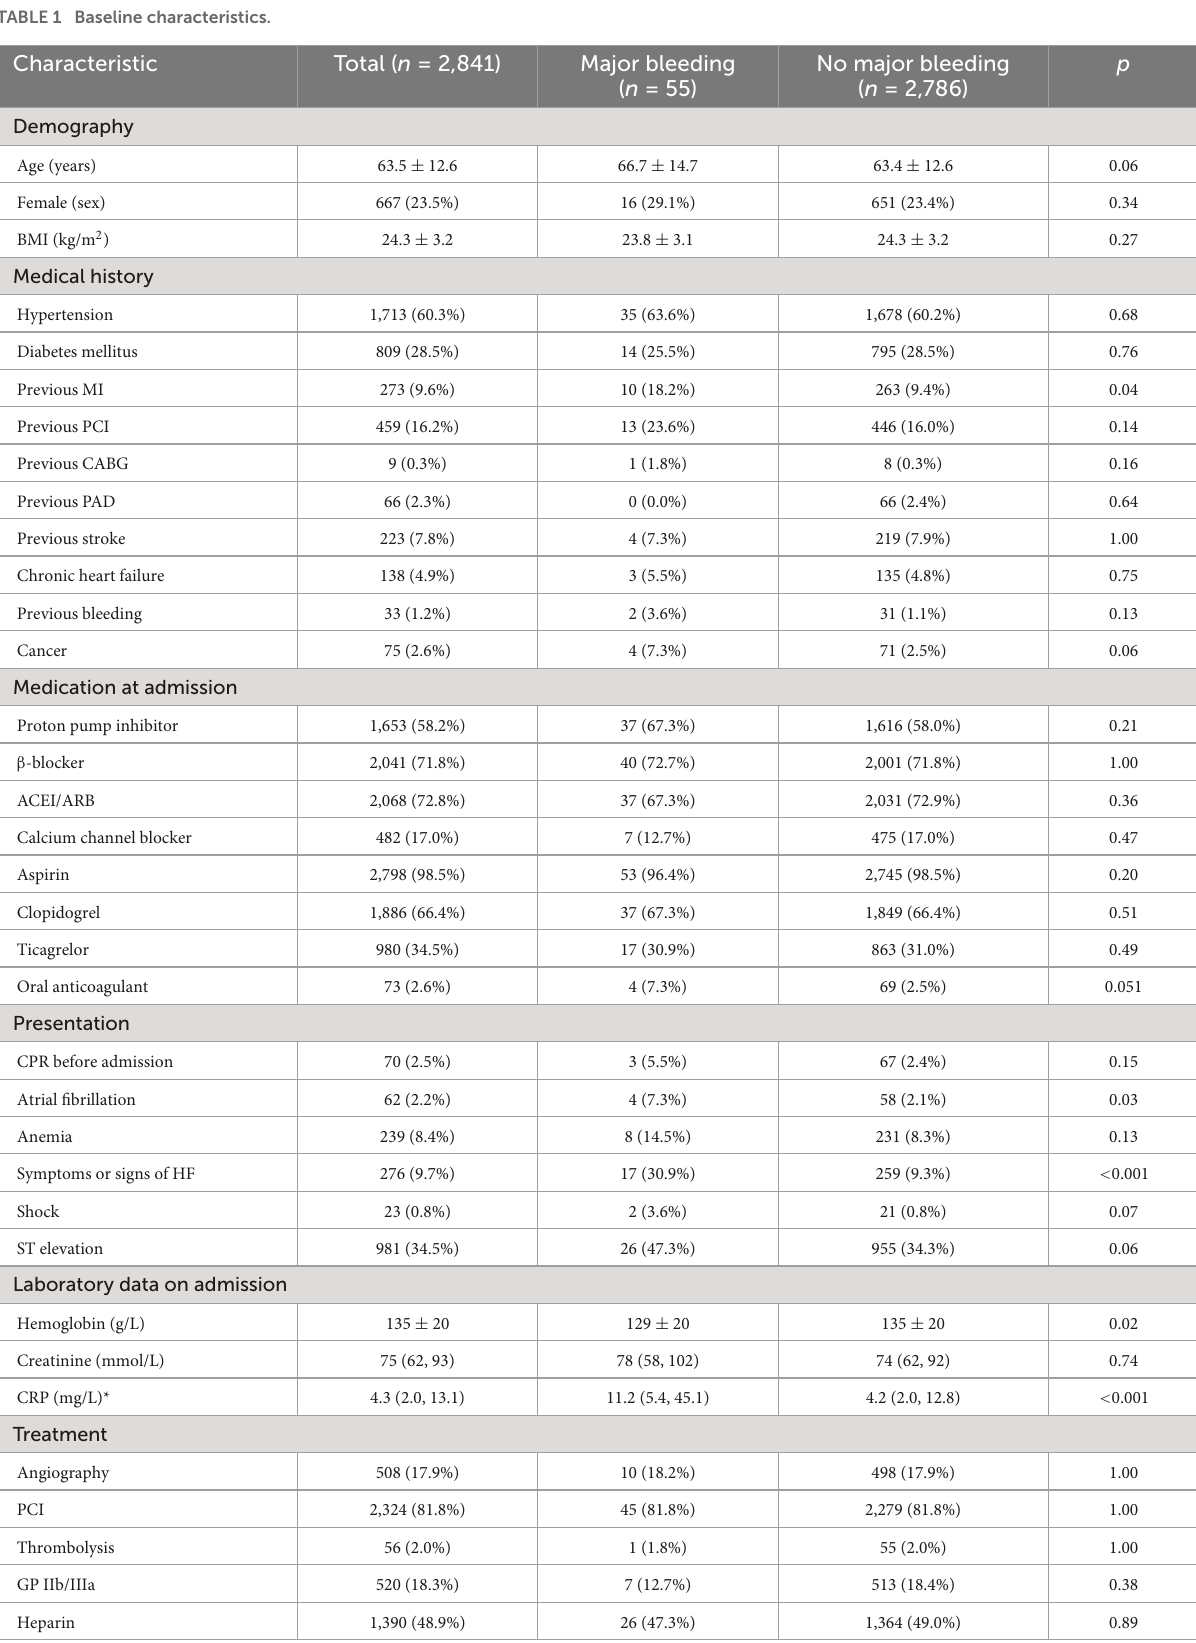
TABLE 1 Baseline